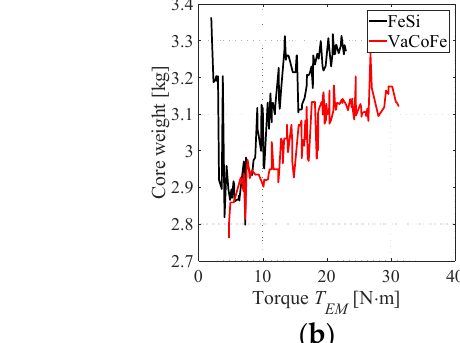
Figure 14. Maximum magnetic flux density of the last generation for FeSi and VaCoFe cores.